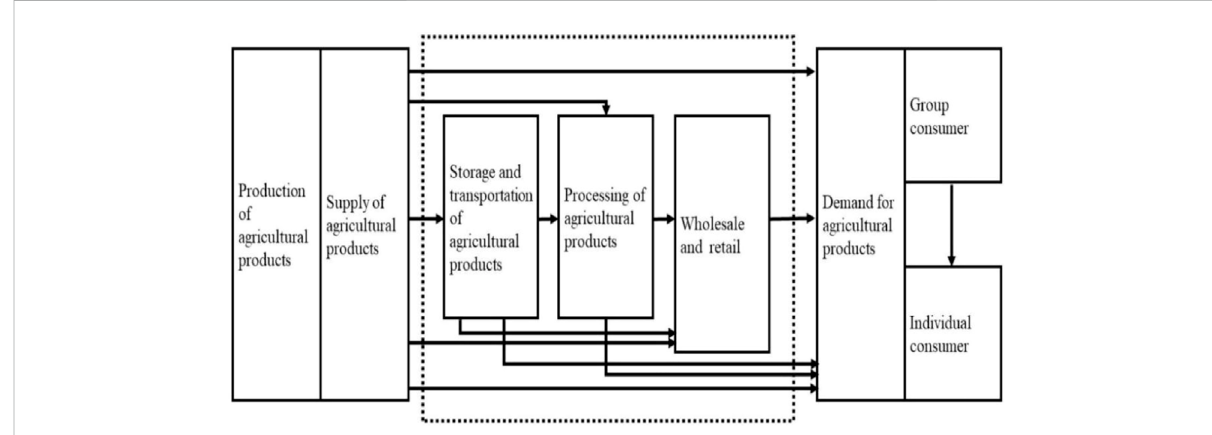
FIGURE 2 Structure of the agricultural industrial chain in Henan Province.